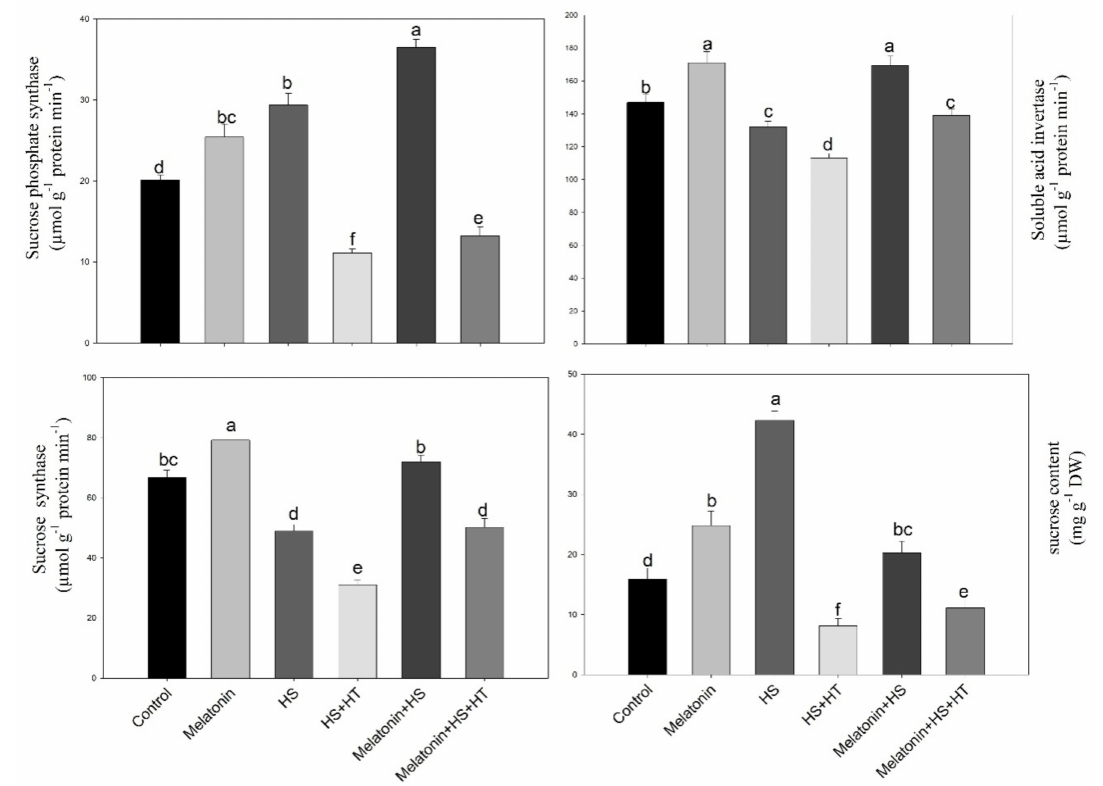
Figure 7. Activity of sucrose phosphate synthase, sucrose synthase, soluble acid invertase and sucrose content in wheat ( Triticum aestivum L. var. WH 542) leaves at 30 days after sowing (DAS). Plants were treated with melatonin (100 µ M) and/or hypotaurine (HT, 100 µ M) in the presence of (40 ◦ C) or absence (25 ◦ C) of heat stress. Data are presented as means ± SE ( n = 4). Data followed by the same letter are not significantly different by LSD test at p < 0.05. HS, heat stress; HT;